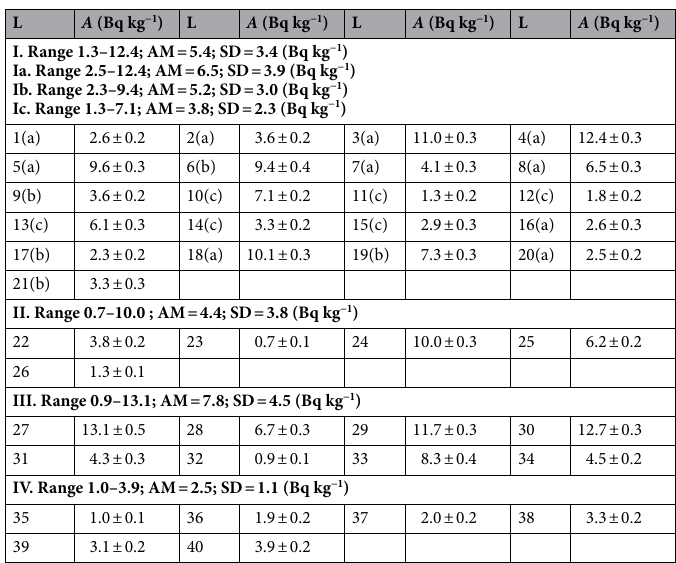
Table 1. Activity concentrations of 137 Cs in mosses sampled at locations L = 1–40 that are shown in Fig. 1. Results are presented in Bq per kg of dry mass, with uncertainties expressed using the coverage factor two. For area I, letters in brackets next to location numbers indicate the type (Ia, Ib, Ic) of terrain. Ranges of measured values, AM, and SD are listed for sampling areas I-IV and also for terrain types Ia, Ib, and Ic. If all samples are treated as a single dataset, the range of values is 0.7–13.1 Bq kg −1 , whereas AM = 5.3 Bq kg −1 and SD = 3.7 Bq kg −1 .